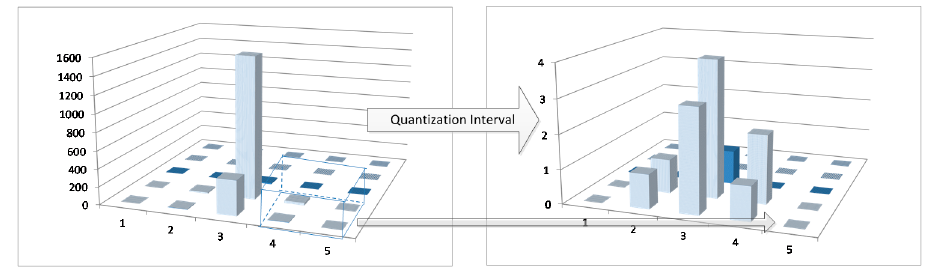
Figure 2. Procedure for 4 quantization levels with mask matrix M ∗ of size 2 × 2.